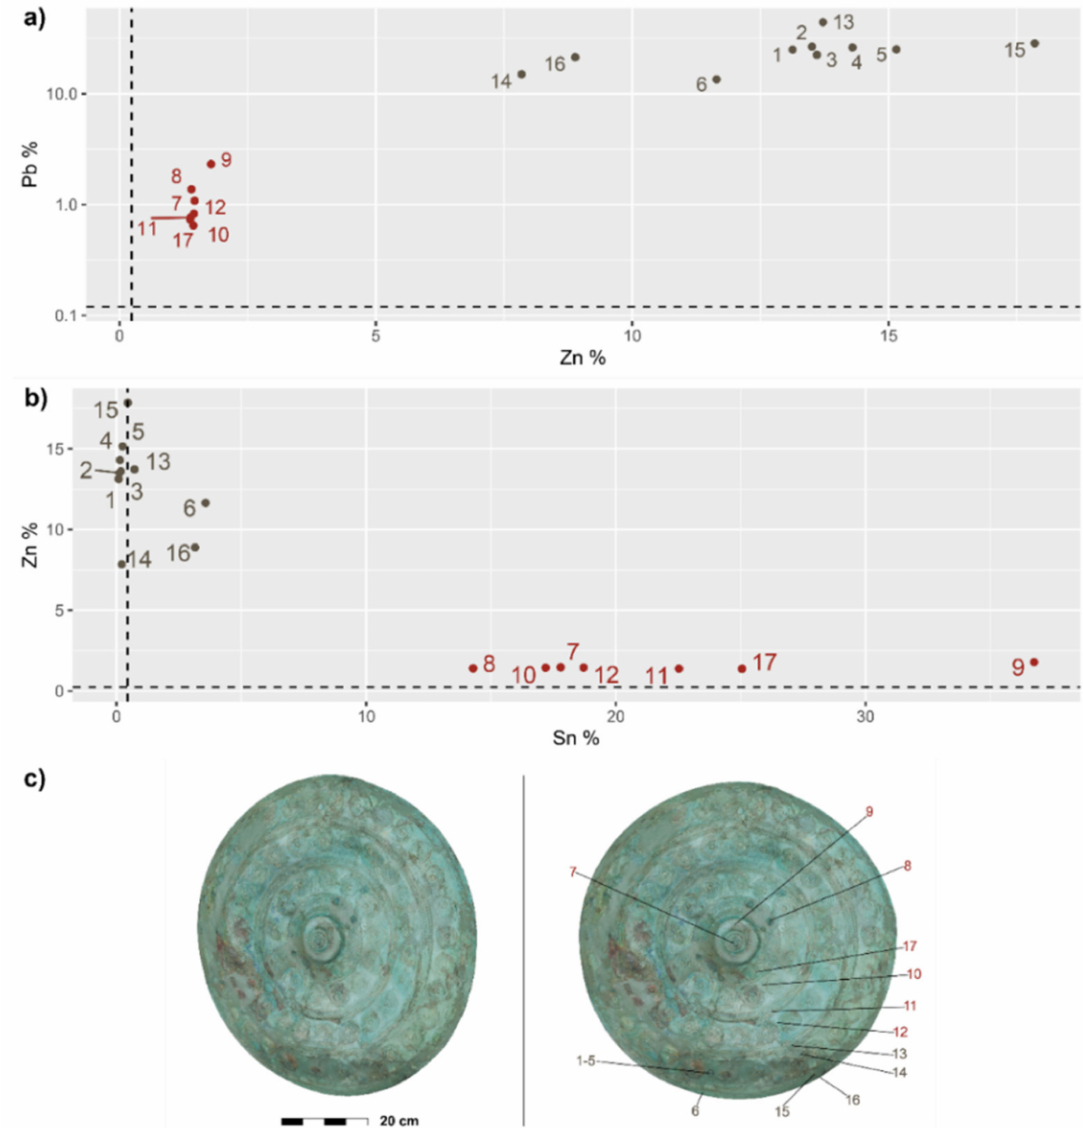
Figure 4. ( a ) Scatter plot of Pb and Zn, ( b ) scatter plot of Zn and Sn, ( c ) Assay locations on VG013 (shield from Veii, Casale del Fosso, tomb 871). Grey represents assays on reconstructed material. Red represents assays represent assays on ‘original’ material. Dashed lines indicate the limits of